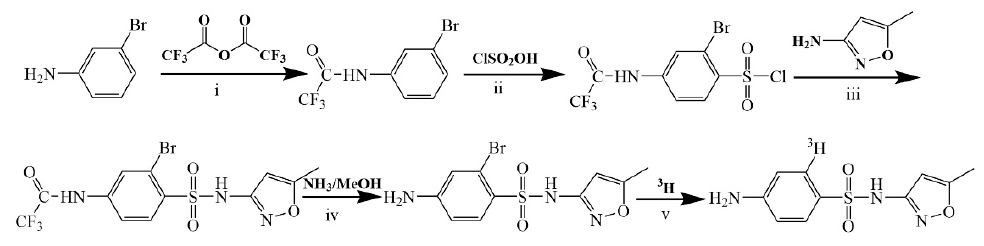
Figure 2. Synthesis scheme of [ 3 H]-SMZ.